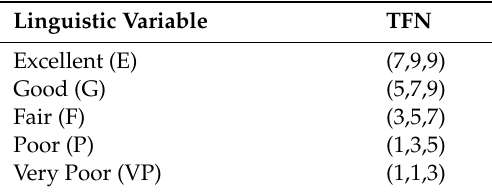
Table 7. Linguistic preference in terms of